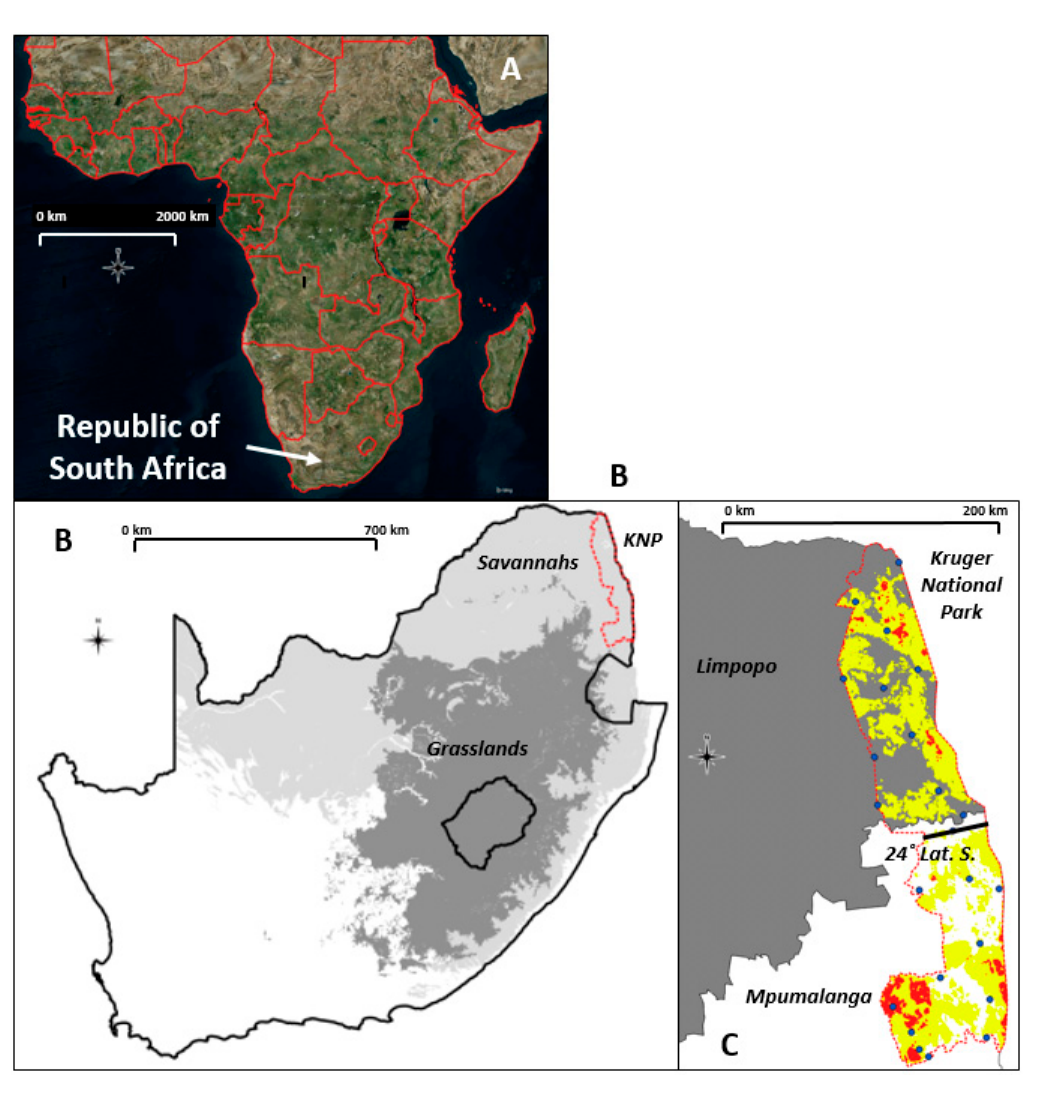
Figure 1. ( A ) The Republic of South Africa on the African continent, ( B ) Savannah (light grey) and grassland (dark grey) biomes that cover 65% of South Africa, ( C ) Kruger National Park (KNP) (park boundary as red dashed line) showing the fire return frequency between 2000 and 2010 (red every 2 years, yellow 3–5 years, rest > 5 years) after [5], blue dots show the location of the KNP weather stations. The 24th degree of South Latitude (bold black line) demarks the limit between the drier northern and the wetter southern parts of the park and corresponds approximately to the 500 mm mean annual precipitation isohyet.